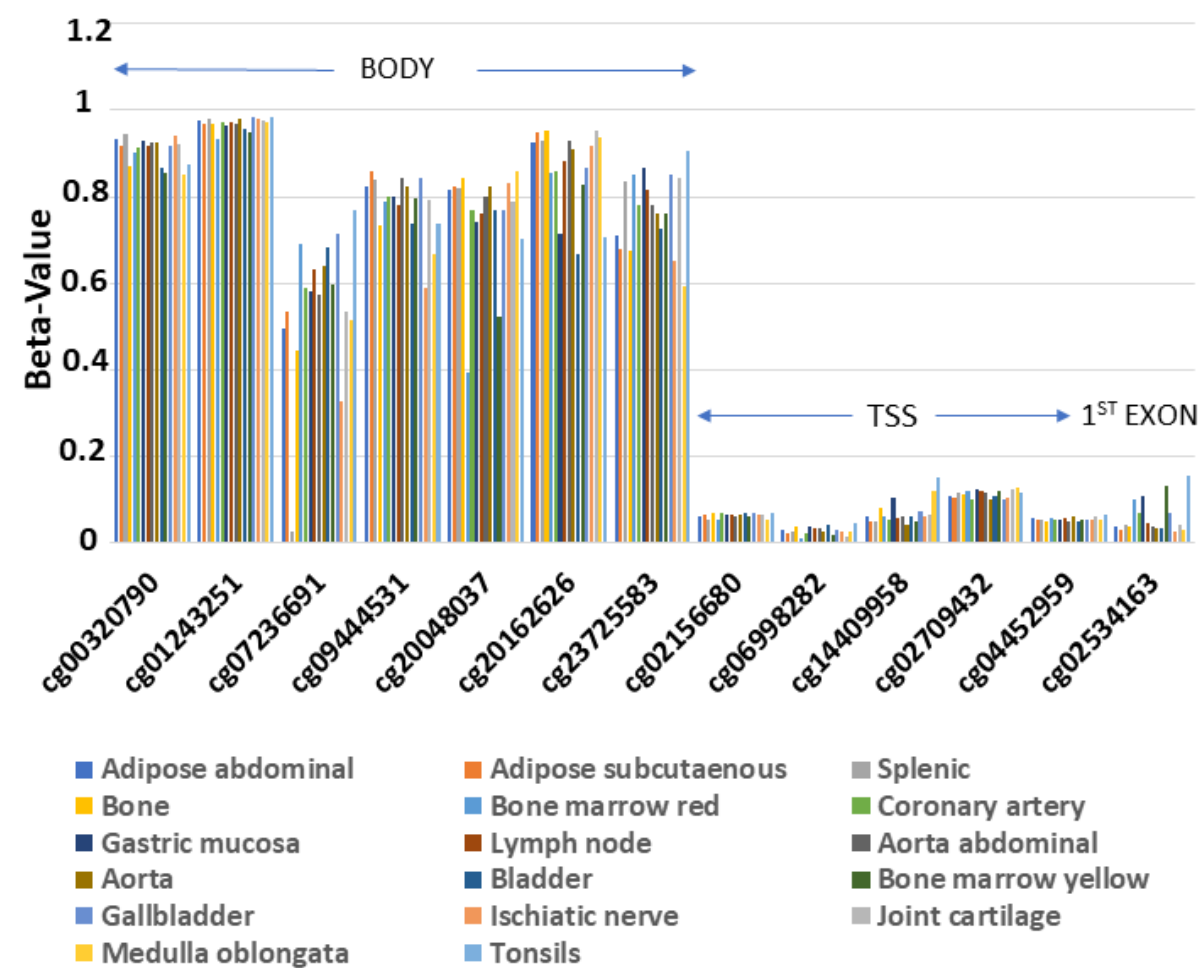
Figure 2. Similar methylation pattern of ENPP2 across 17 healthy tissues. Gene body region presents higher methylation levels in relation to TSS or 1st exon. Abbreviations: TSS = Transcription Start Site.